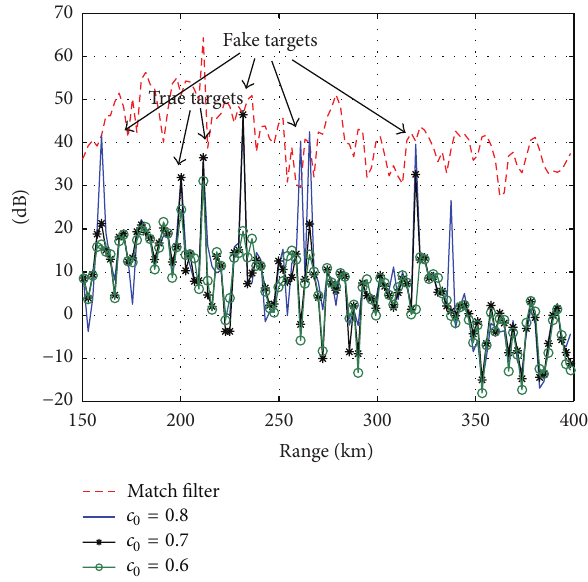
Figure 13: The results by using the improved-JDL for multitarget situation.